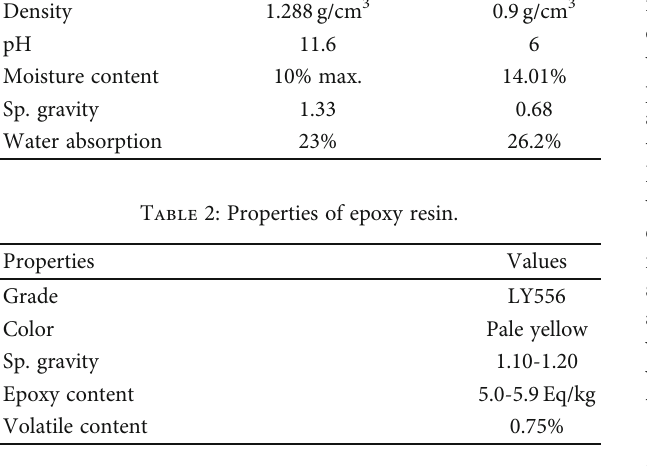
Table 3: Material composition.